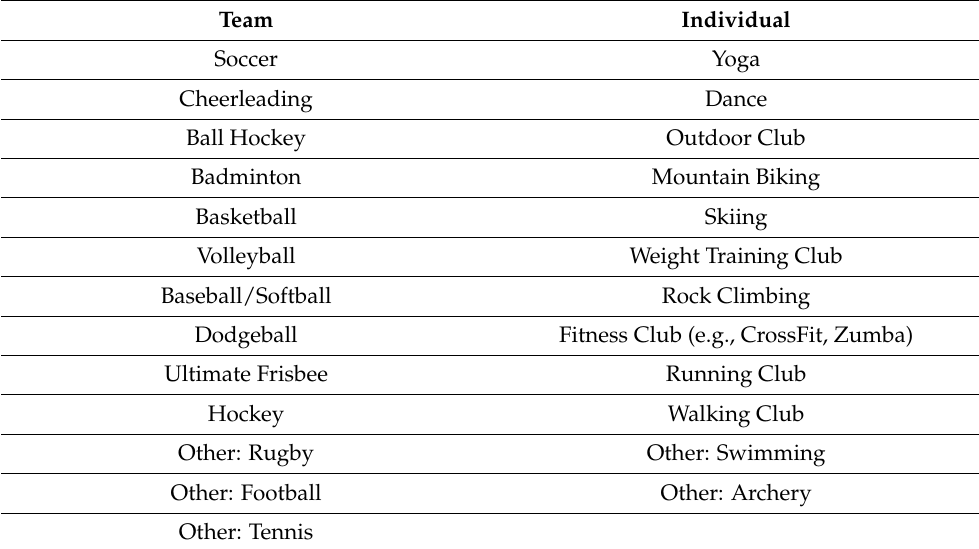
Table A1. Classification of intramurals into team and individual